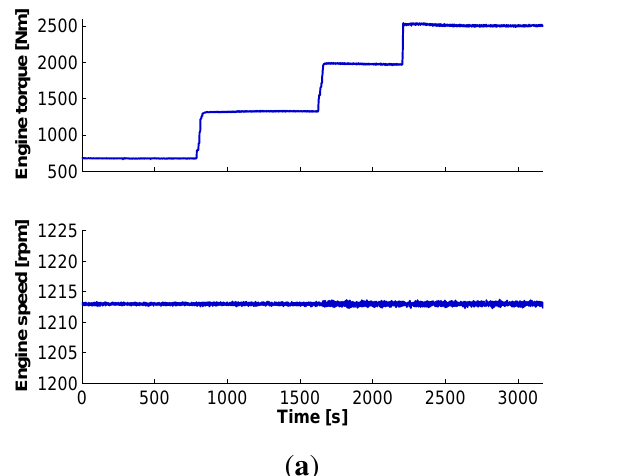
Figure 7. ( a ) Engine torque and speed; ( b ) Engine exhaust gas heat flow rate and the operating region signal.